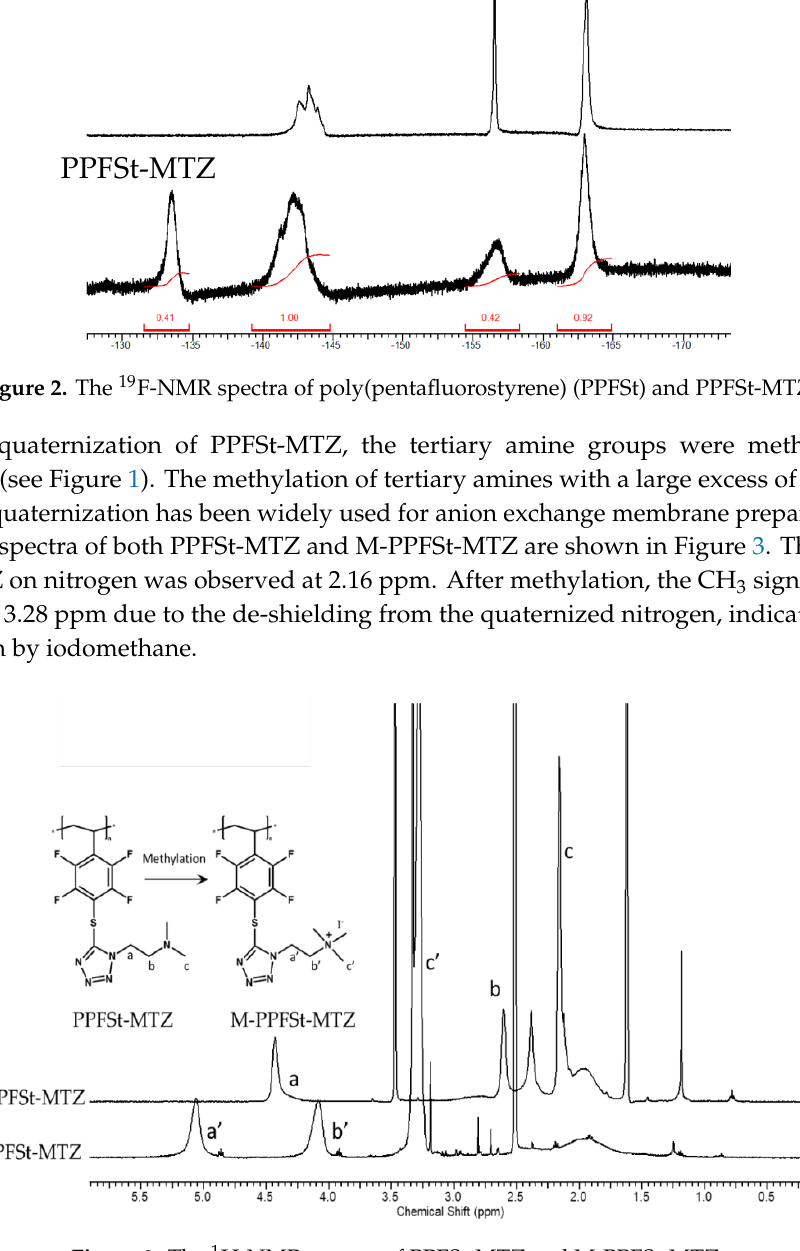
Figure 1. Anion exchange polymer preparation.